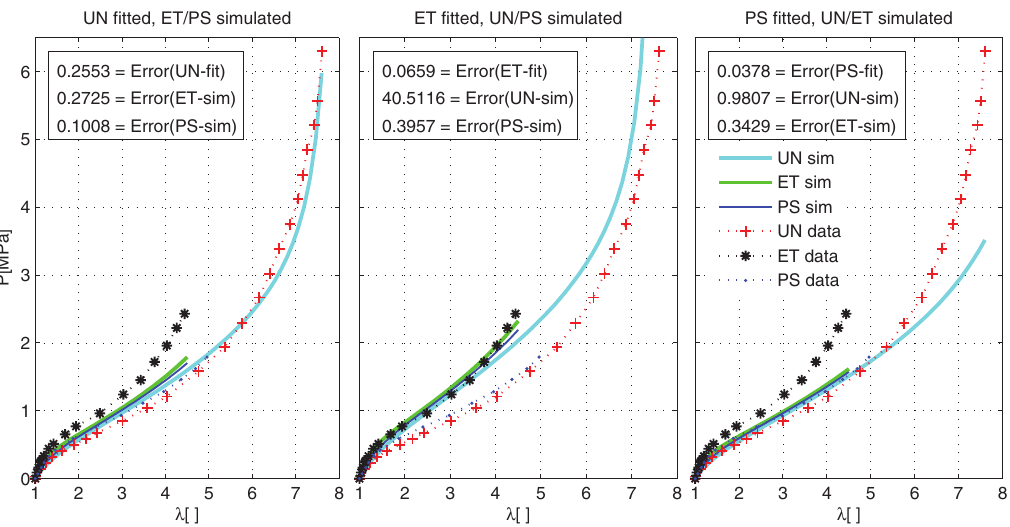
Figure 8: Performance of the full-network model on the Treloar